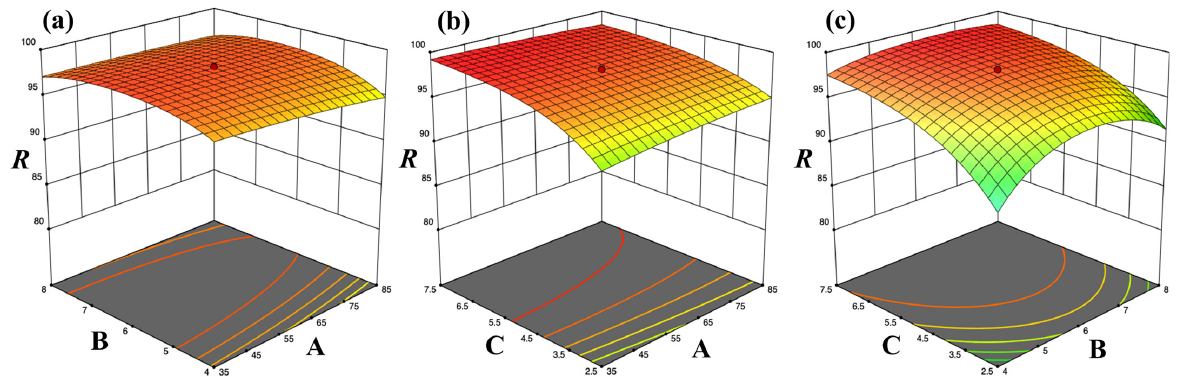
Figure 4. Response surfaces at the central point levels for SUWS biosorbent: ( a ) effect of CV concen- tration (A) and pH (B), ( b ) effect of CV concentration (A) and biosorbent dose (C), ( c ) effect of pH (B) and biosorbent dose (C) on removal efficiency ( R